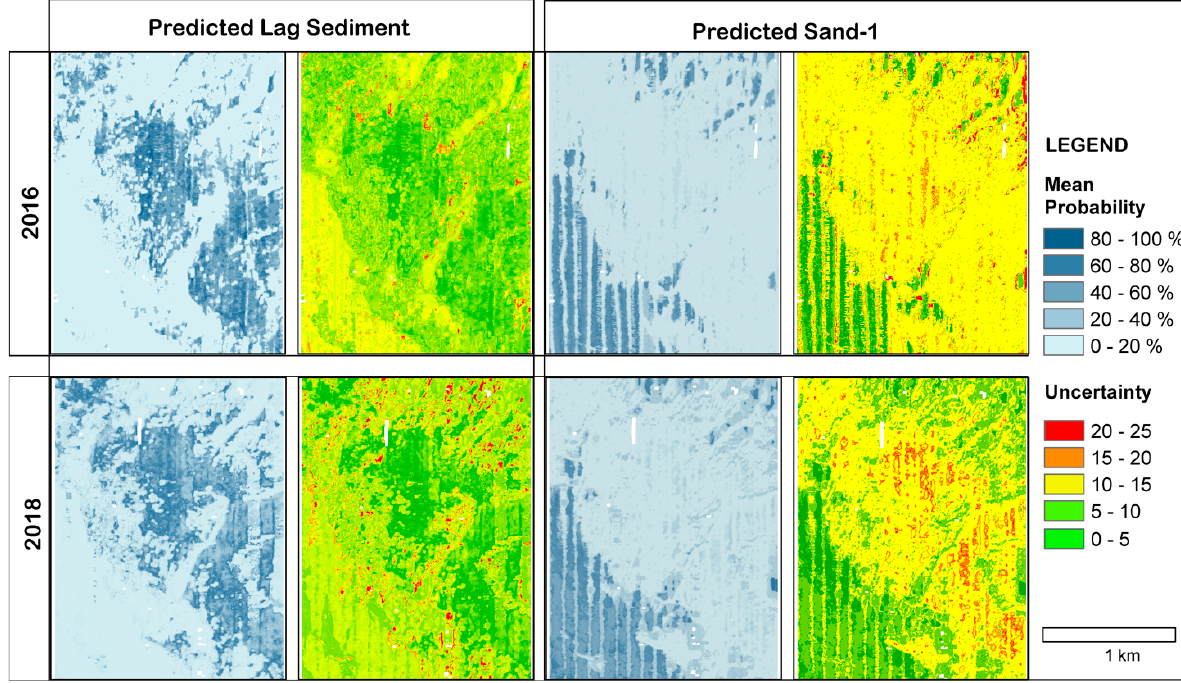
Figure 5. Predicted seafloor sediment classes in H3 for the year 2016 and 2018. Mean probability should be interpreted with the uncertainty map as a reference. Areas with high uncertainty (red color) indicates low confidence that LagSed and Sand will occur in that location.